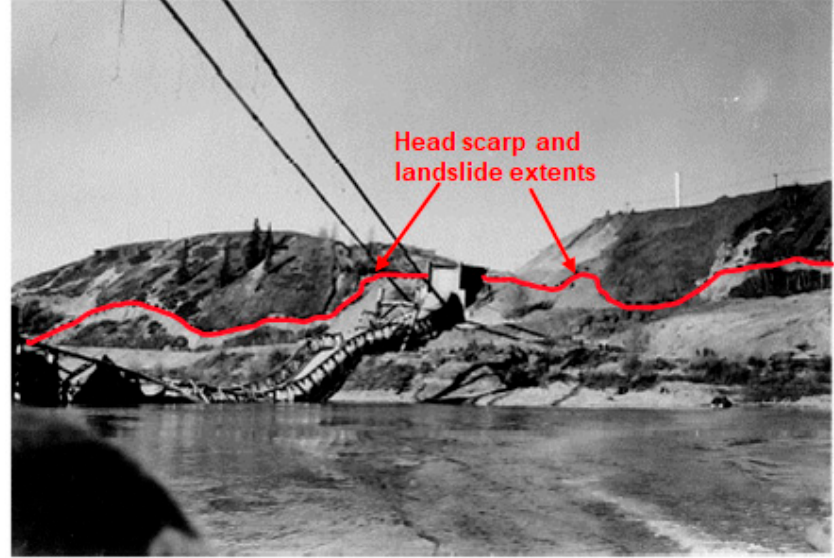
Figure 3. Peace River Bridge Landslide, after [21] (with permission).